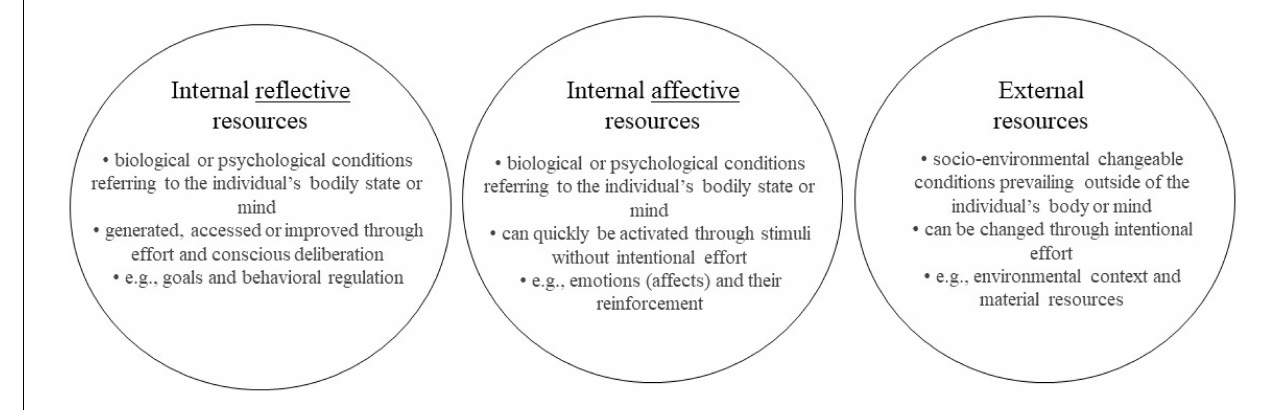
FIGURE 1 | Behavior change resource clusters.